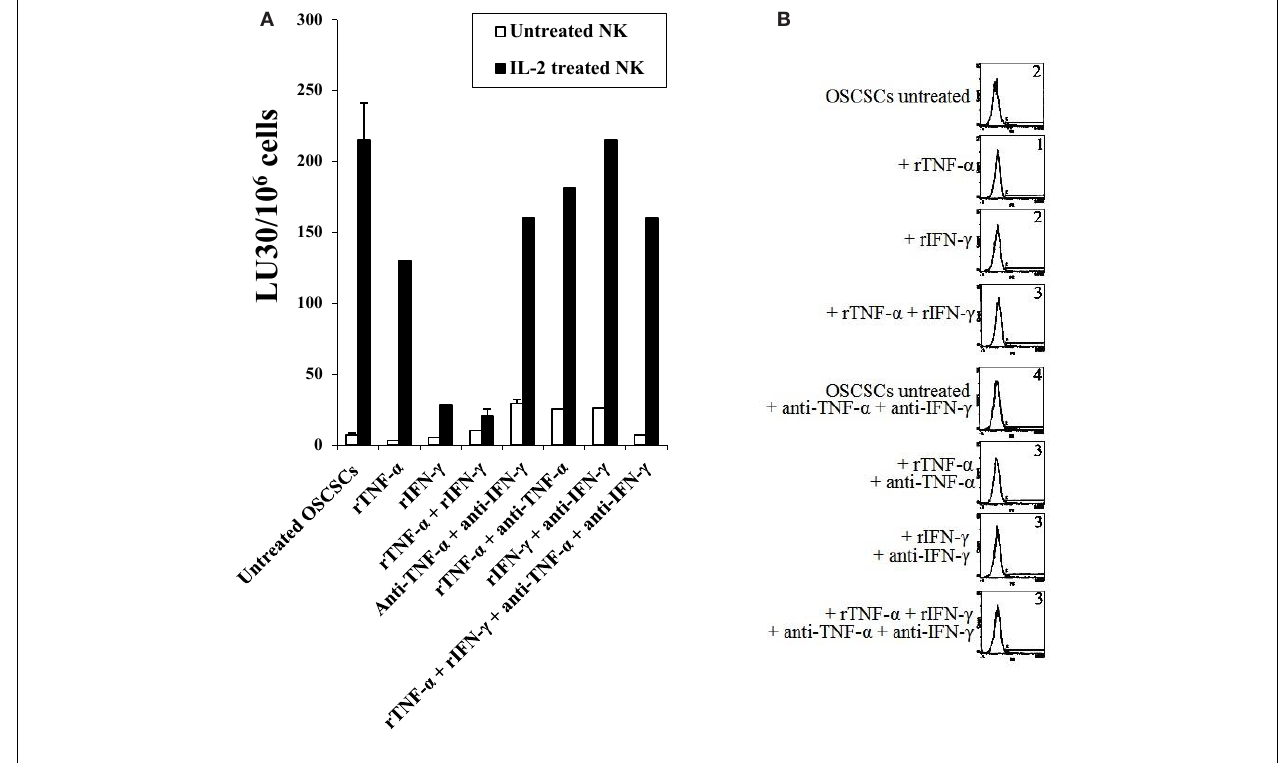
were determined using inverse number of NK cells required to lyse 30% of the tumor cells × 100. OSCSCs were treated as described in Figure 2A and their viability was assessed using propidium iodide staining followed by the flow cytometric analysis (B) . Surface expressions of CD54, CD44, B7H1, and MHC-1 on OSCSCs (C) treated as described in Figure 2A were determined using staining with PE-conjugated antibodies followed by flow cytometric analysis. Isotype control antibodies were used as controls.The numbers on the right hand corner are the percentages and the mean channel fluorescence intensities in each histogram. One of minimum three representative experiments is shown in each of (A–C)